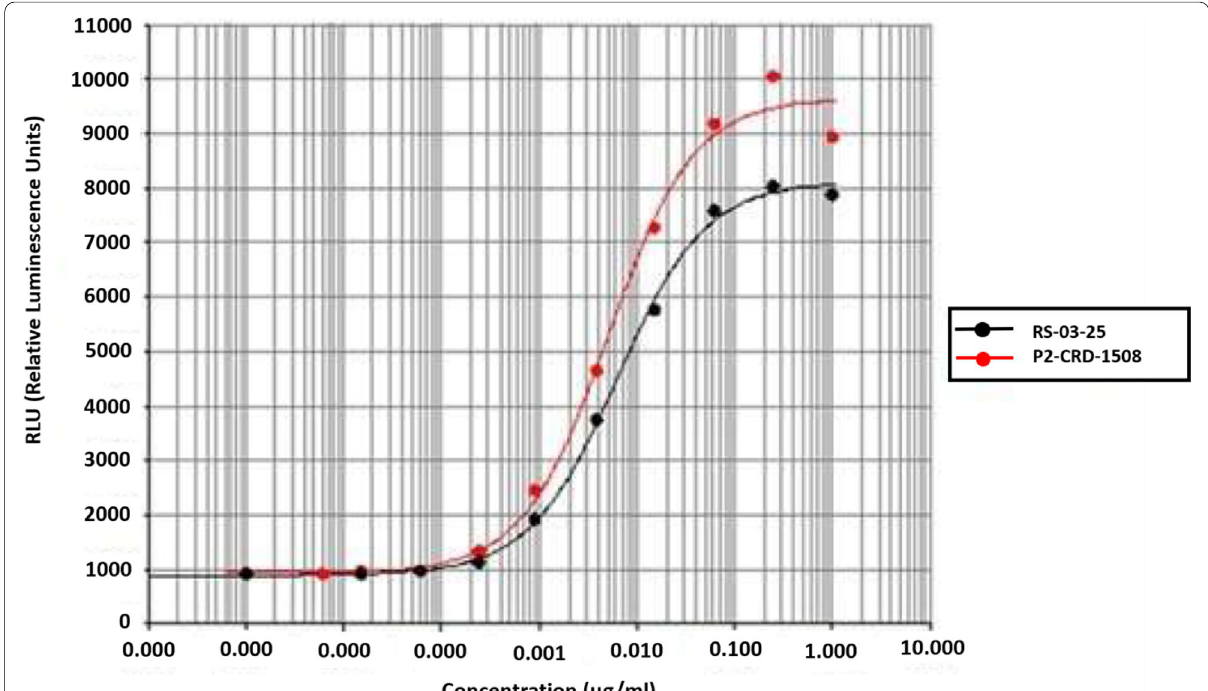
Fig. 3 Dose response curve generated by parallel line analysis (PLA) for ADCC activity of test anti-CD20 antibody and control antibody. The test antibody P2-CRD-1508 showed higher ADCC activity due to increase in afucosylation (decrease level of fucosylation) over the control